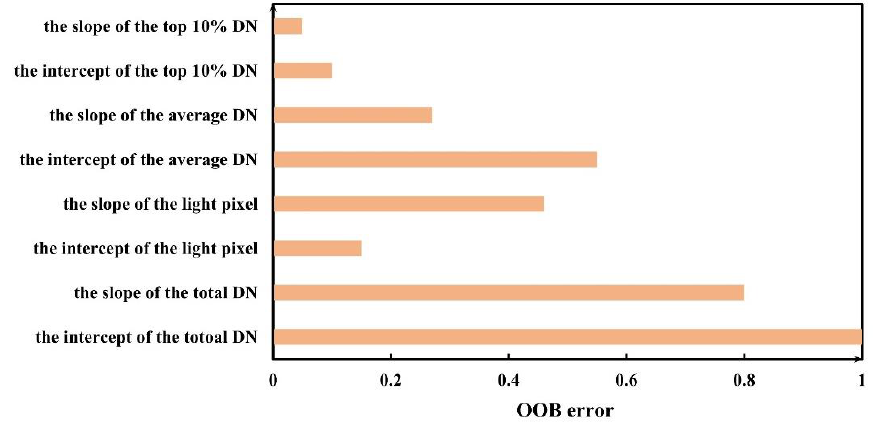
Figure 5. ( a ) The cross-sensor calibration results, with Changchun city, capital of Jilin Province, as an example: the total DN of calibrated time series of NTL data from 1996–2020; ( b ) the original DMSP grc image in 2009; ( c ) the VIIRS image in 2017; and ( d ) the calibrated image in 2009.